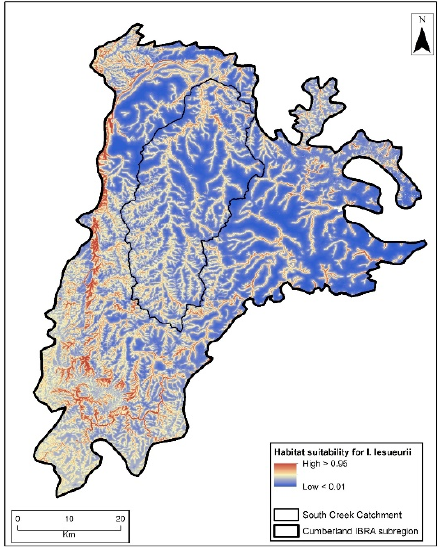
Figure 10. Predicted habitat suitability for the eastern water dragon ( Intellagama lesueurii), in the Cumberland Interim Biogeographic Regionalisation of Australia (IBRA) subregion.